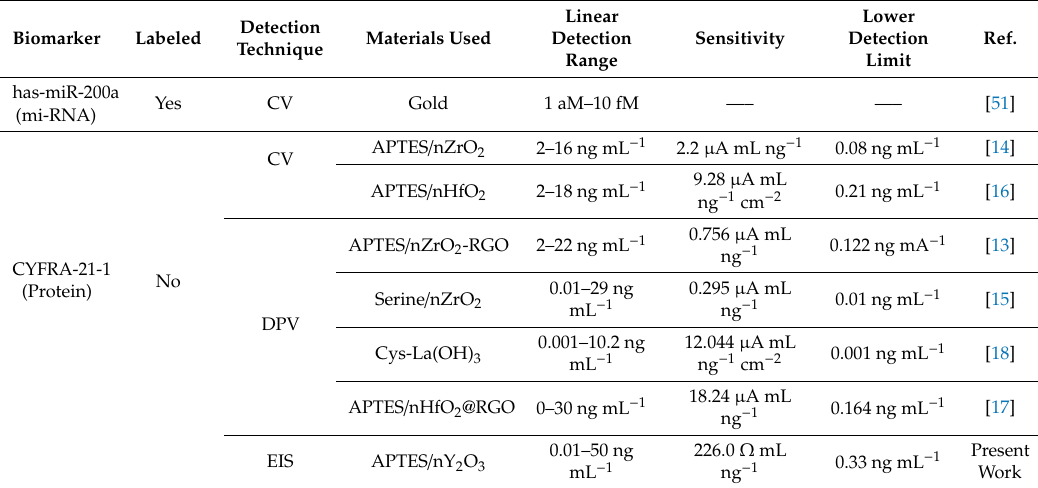
Table 1. Characteristics of the BSA / anti-CYFRA-21-1 / APTES / nY 2 O 3 / ITO-based biosensor, along with those reported in literature for oral cancer